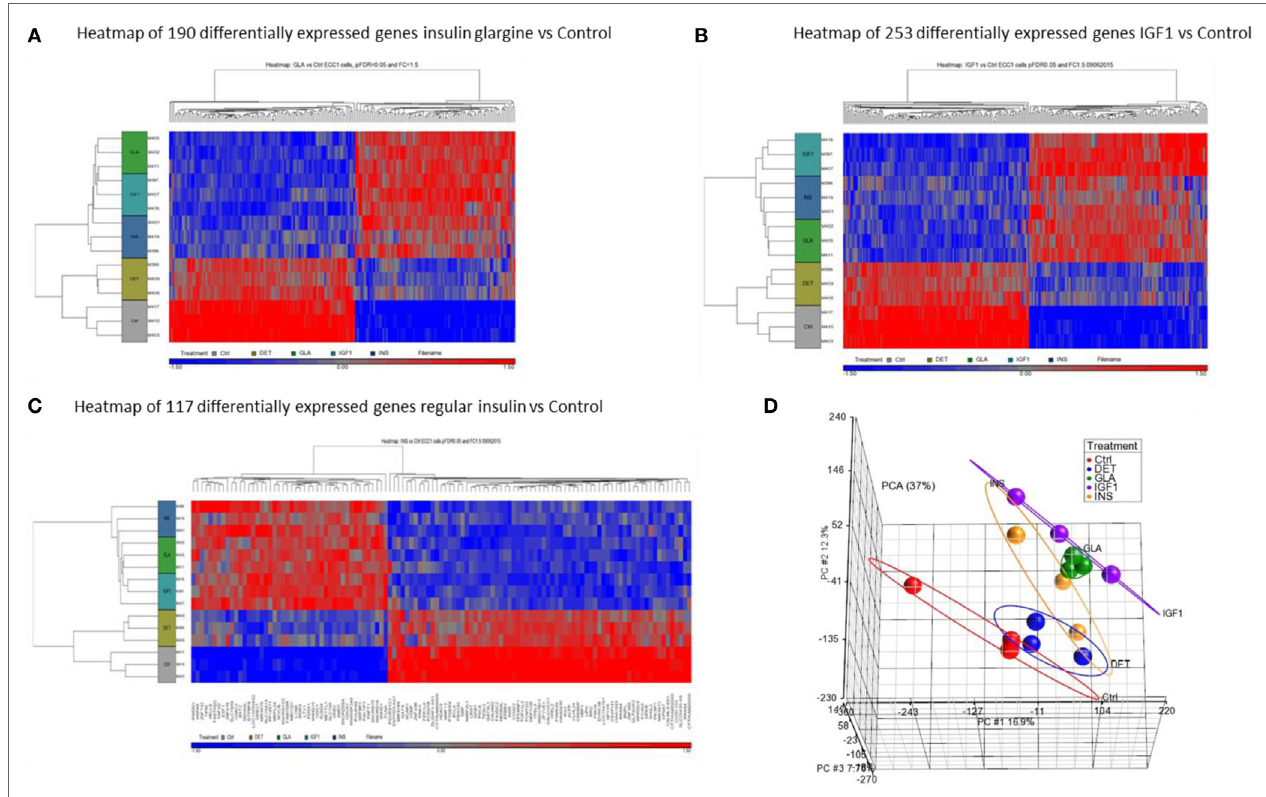
FigUre 1 | Hierarchical clustering map of differential gene expression in ECC-1 cells. Heatmaps of microarray results in the ECC-1 cell line after treatment with insulin glargine (a) , IGF1 (b) , and regular insulin (c) . The figures depict heatmaps of differentially expressed genes [FC > 1.5 or <− 1.5 and p -value (FDR) < 0.05]. The scale below indicates the relative changes in gene expression represented by red (upregulated genes) and blue (downregulated genes) colors. (D) Principal component analysis (PCA) of all 15 arrays of ECC-1 cells (three biological replicates were performed for each treatment). Each data point represents RNA sample applied to microarray: red (untreated cells—Control, Ctrl), blue (Detemir, DET), green (Glargine, GLA), violet (IGF1), and orange (regular insulin, INS).